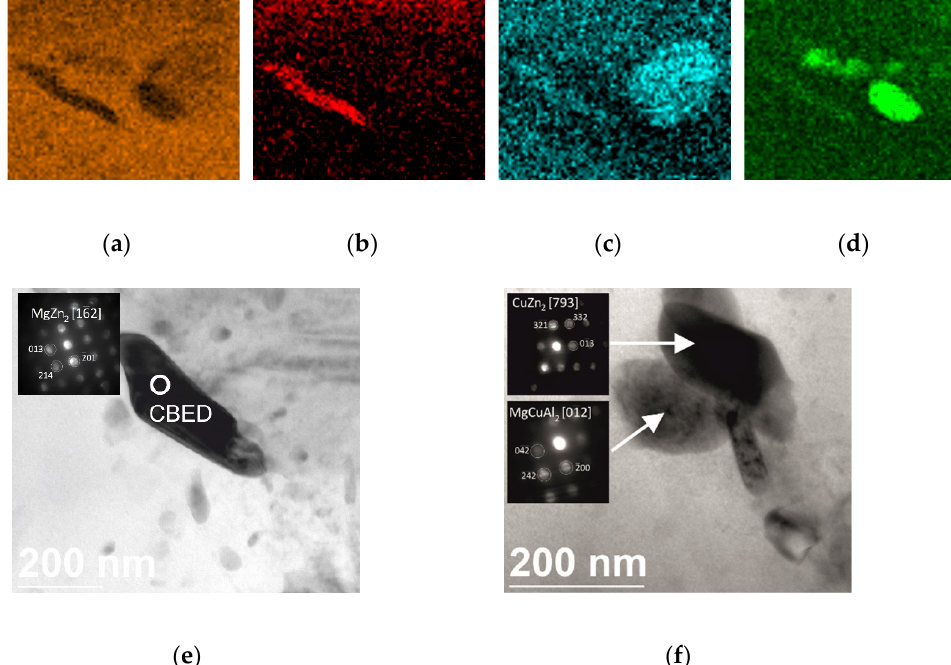
Figure 2. Transverse cross-sectional HAADF STEM micrographs of SPSed AA7075 ( a , b ). Table 2. Chemical composition of precipitates in various areas presented in Figure 2b.